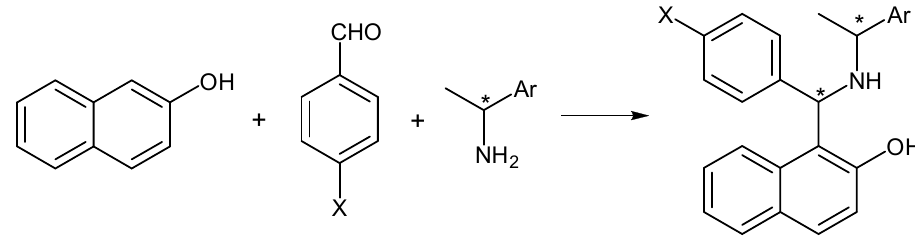
Figure 1. Betti reaction between 2-naphthol, aryl aldehydes and ( S )- or ( R )-1-arylethylamines.